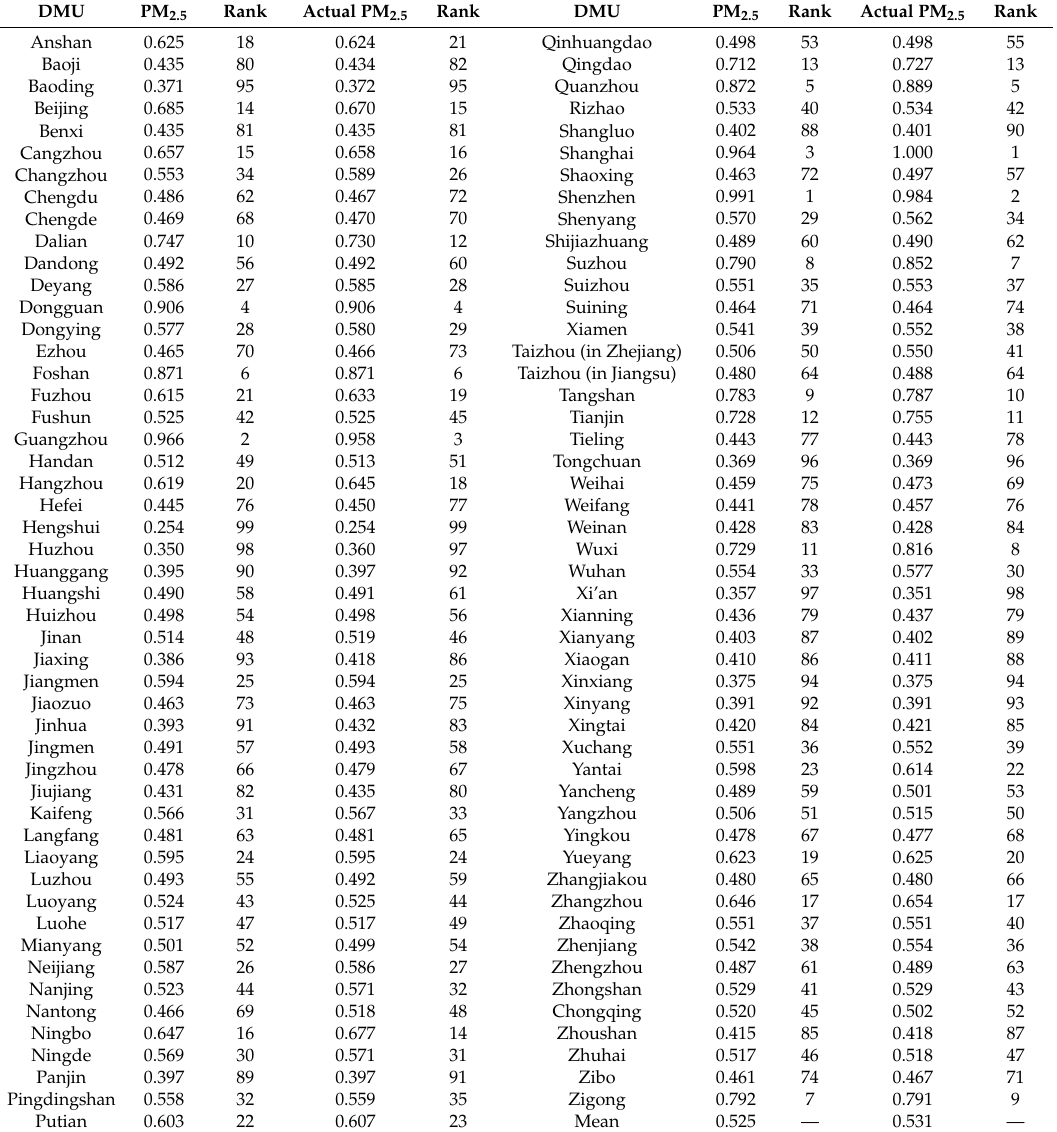
Table 4. The PM 2.5 environmental efficiency and its ranking under meta-frontier during 2004 to 2016.